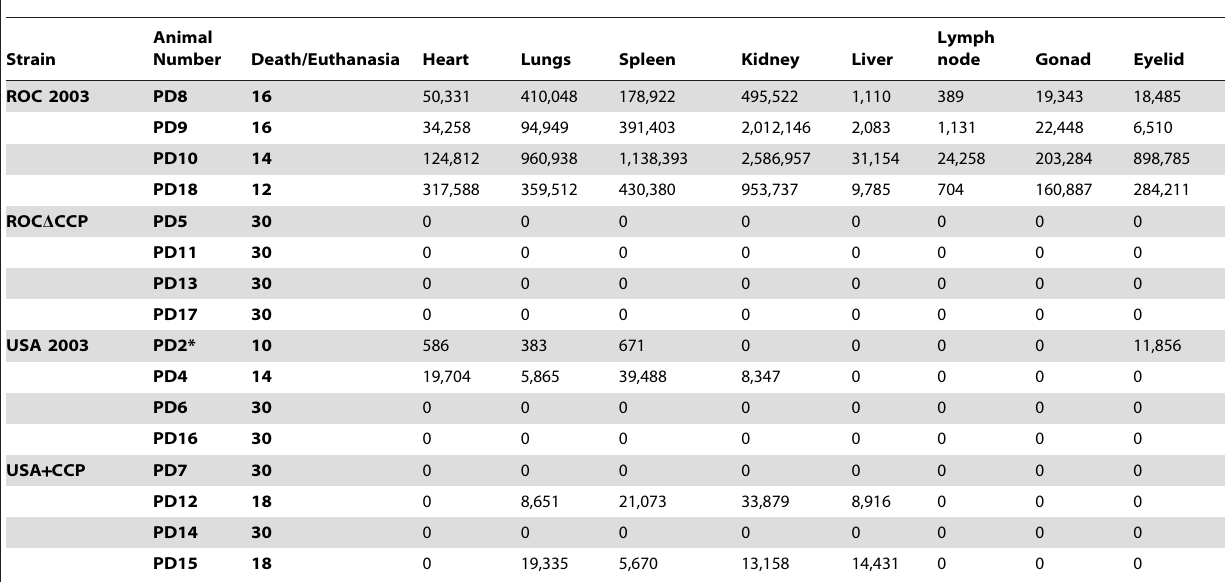
Table 2. Viable virus in animal necropsy tissue samples in plaque-forming unit per gram of tissue.